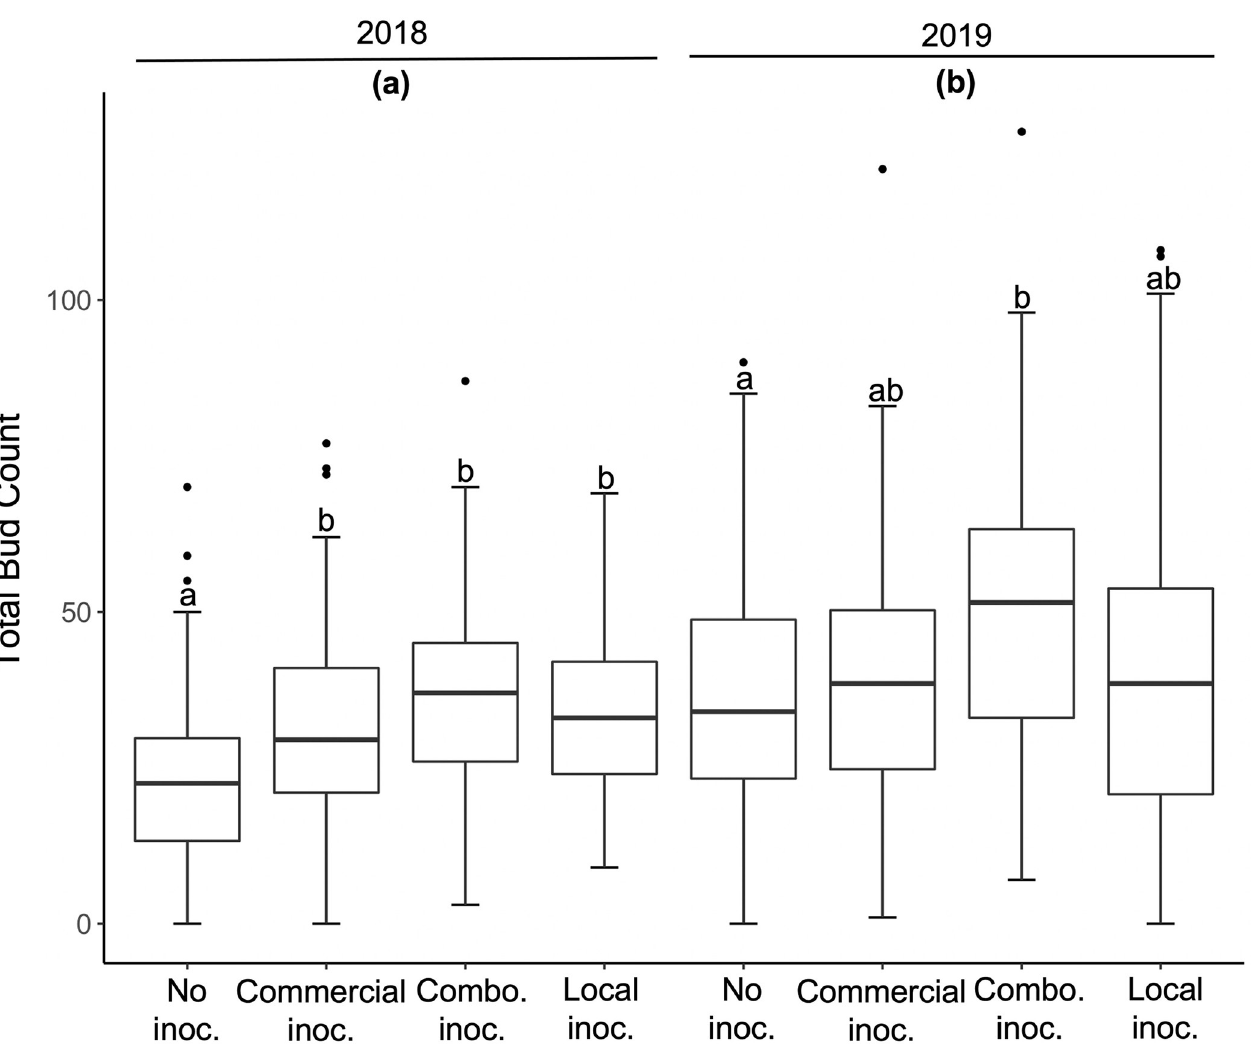
Fig 2. The mean number of inflorescence buds ± 1 standard error formed per plant in each of the four treatments in 2018–2019. Results were analyzed with a linear mixed effects model. Letters denote significant differences among treatments within years groups using R package “emmeans”.